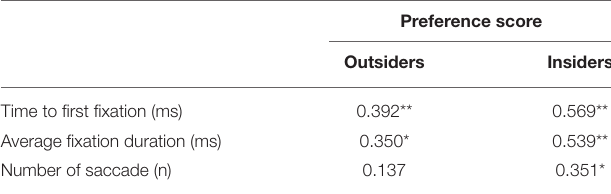
TABLE 2 | Correlations between the scores of landscape preferences and the time to first fixation, the average fixation duration, and the number of